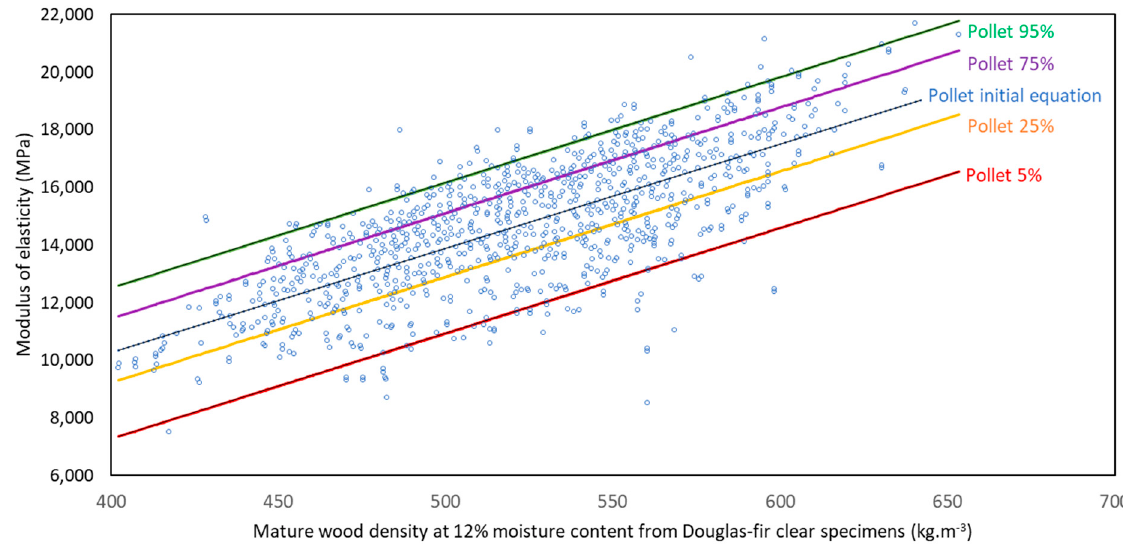
Figure 1. Linear regressions from the relationship between density and longitudinal modulus of elasticity for mature Douglas-fir clear specimens from Pollet [8].